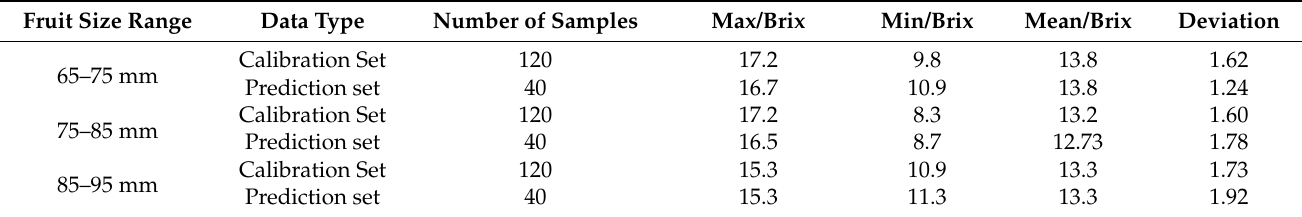
Table 1. SSC values for apples of different fruit sizes.